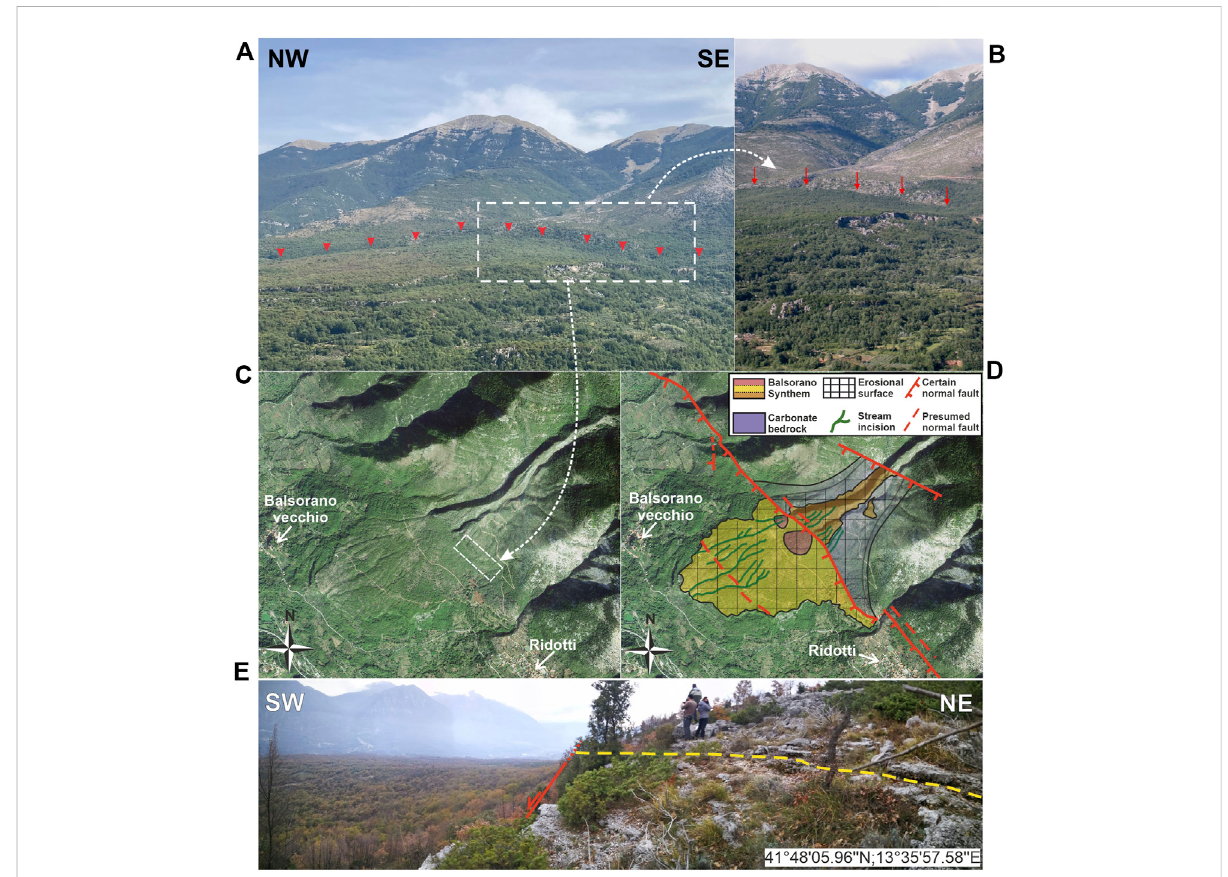
FIGURE 4 (A) Panoramic view (view to NE) of the eastern fl ank of the Roveto Valley in the Balsorano area, where the deposits pertaining to the “ Balsorano Synthem ” crop out. The Roveto Valley fault escarpment is indicated by red arrows. (B) Detail of the fault escarpment (red arrows) crosscutting the Balsorano Synthem. (C) Satellite image (from Google Earth) of the Balsorano Synthem. (D) Simpli fi ed geological and geomorphological scheme of the Balsorano Synthem. The different colors of the Balsorano Synthem refer to the different facies. (E) Details of the fault escarpments that crosscut the Balsorano Synthem; the yellow dashed line indicates the sub-horizontal attitude of the deposit layers at the fault footwall; the red line indicates the fault scarp that truncates the deposit layers, leaving them hanging over the present valley